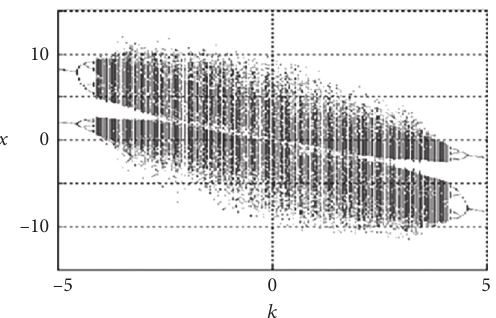
Figure 2: Bifurcation diagram of Chen’s chaotic system with parameter k